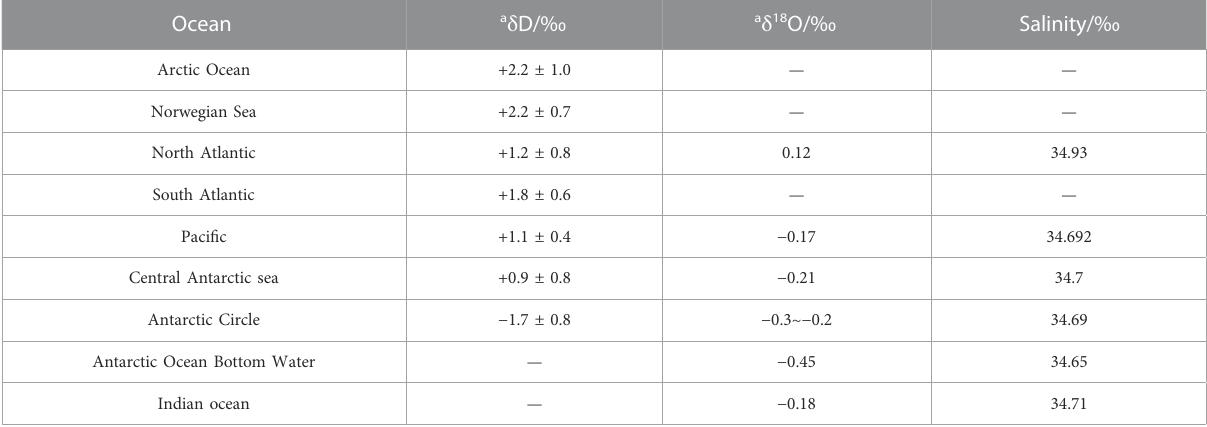
TABLE 6 Hydrogen isotopic composition of deep seawater.